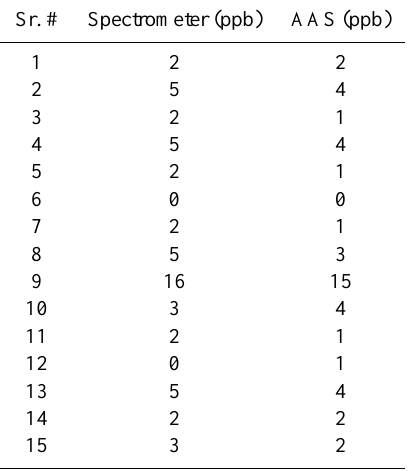
Table 3. Spectrometer vs. AAS (As Analysis). Sr. #